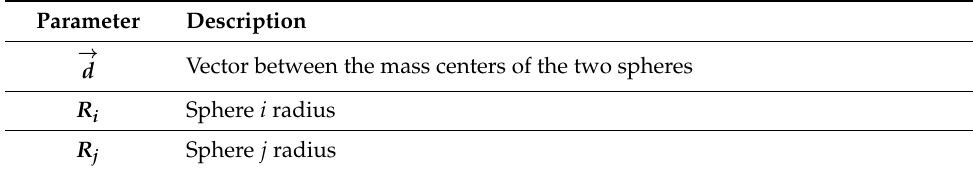
Table 2. Summary of the parameters required to calculate the indentation between two spheres. Parameter